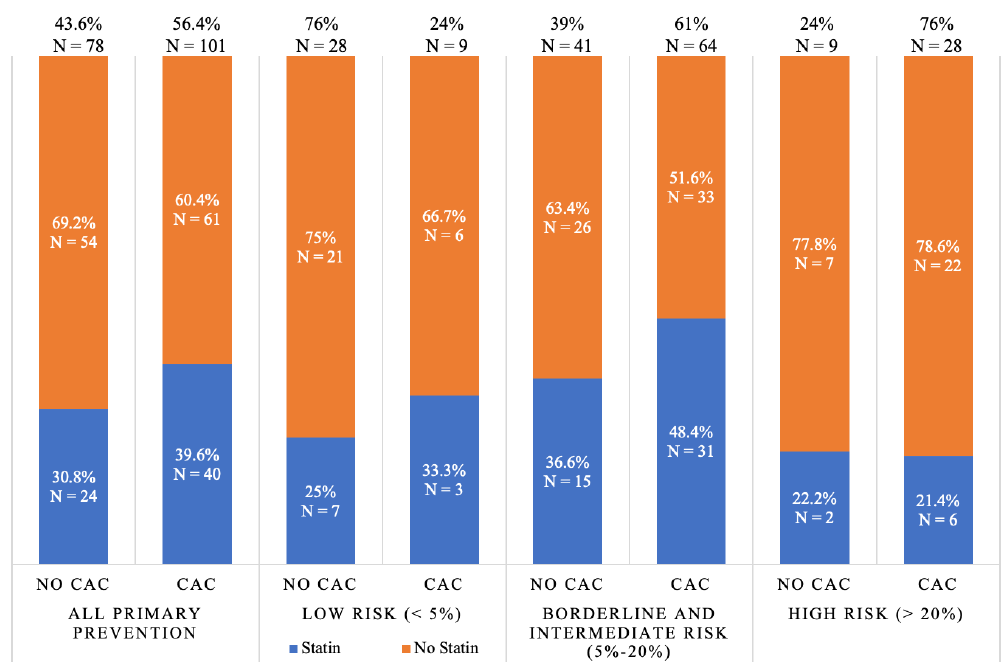
Figure 3. Prevalence of statin therapy at the time of admission relative to the presence or absence of CAC and ASCVD risk in the primary prevention group. Data limited to the 179 patients for which ASCVD risk and statin therapy information were available. CAC—coronary artery calcification, ASCVD risk—atherosclerotic cardiovascular risk score by the Pooled Cohort Risk Calculator.